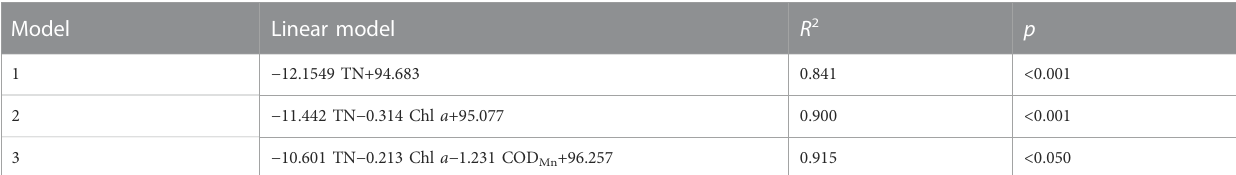
TABLE 1 Stepwise linear regression of WQI with parameters examined after normalizing.